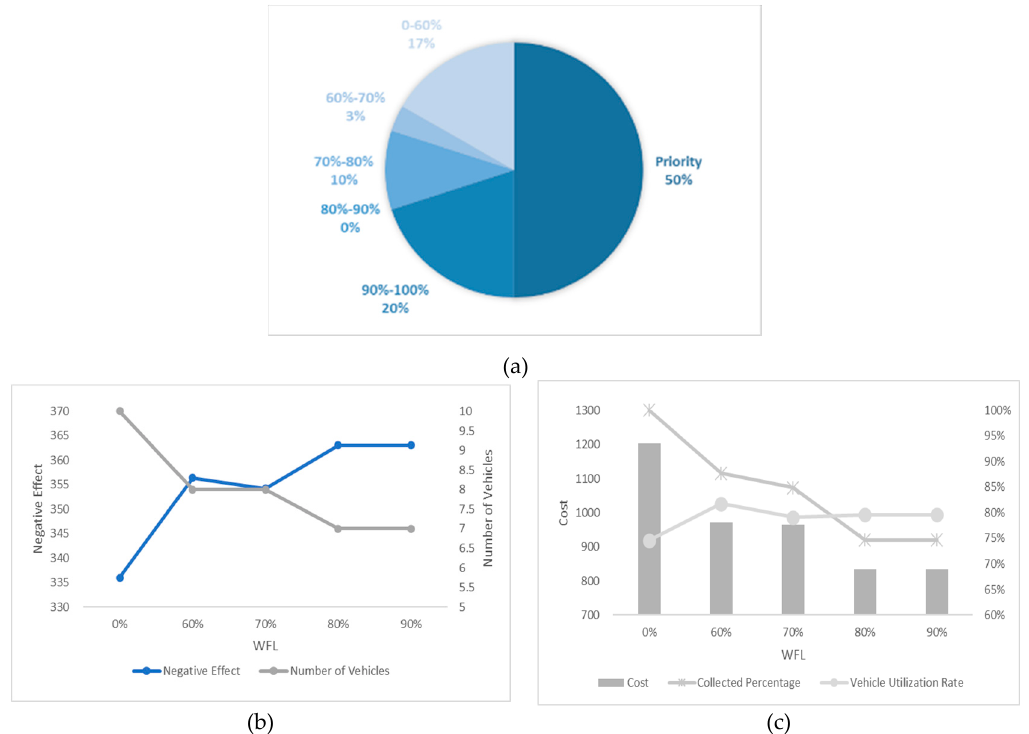
Figure 14. Results with 15 high-priority waste bins. ( a ) PCS-15 distribution of various waste bins, ( b ) PCS-15 negative effect and number of vehicles and ( c ) PCS-15 cost and vehicle utilization rate.